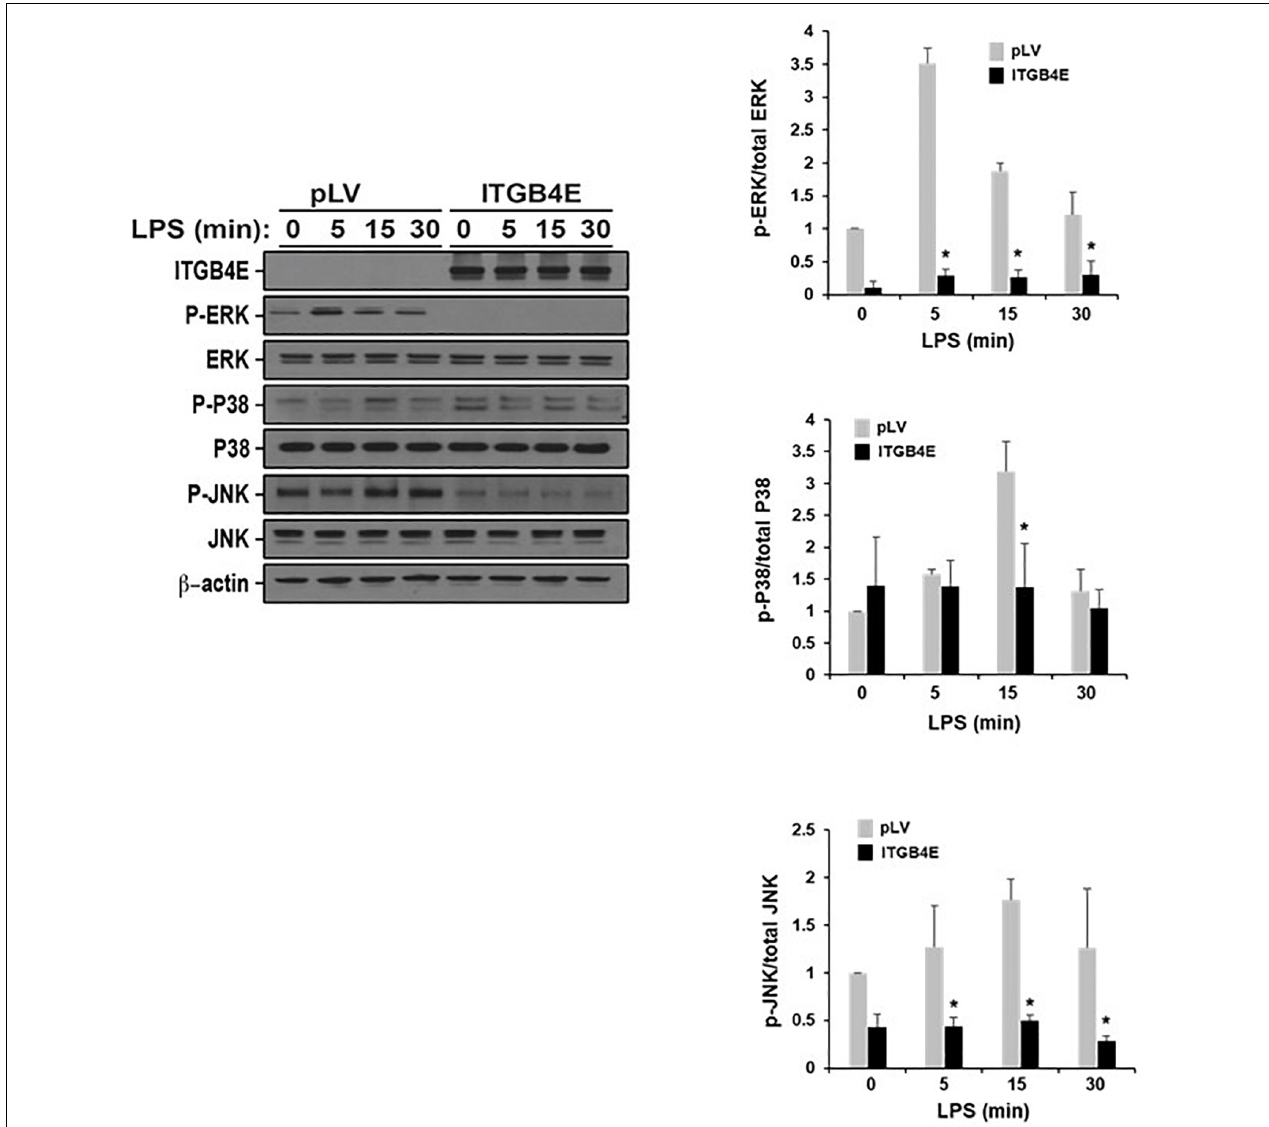
FIGURE 5 | Reduced lipopolysaccharide (LPS)-induced EC mitogen-activated protein kinase (MAPK) activation associated with ITGB4E overexpression. Human pulmonary artery ECs were transfected with ITGB4E or control vector (pLV) prior to treatment with LPS (100 ng/ml) for various time points (0, 5, 15, or 30 min). Lysates were then collected and used for Western blotting for total and phosphorylated Erk, p38, and JNK (representative blots shown) (* p < 0.05 compared with pLV